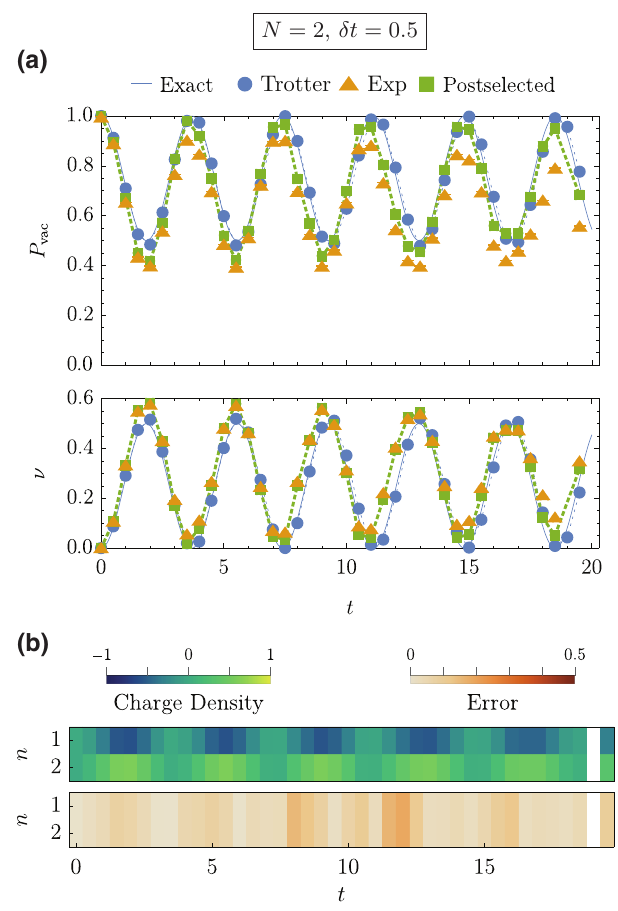
FIG. 5. Experimental results for N = 2 and δ t = 0.5. (a) The upper plot shows fluctuation in the bare-vacuum population, P vac , while the lower plot shows the particle-number density, ν , as a function of time, indicating the creation and annihilation of the particle-antiparticle pairs. The dashed lines are a guide to the eye. (b) The upper plot shows the local charge density Q n as measured in the experiment after postselection, while the lower plot shows its deviation from theory as a function of time.